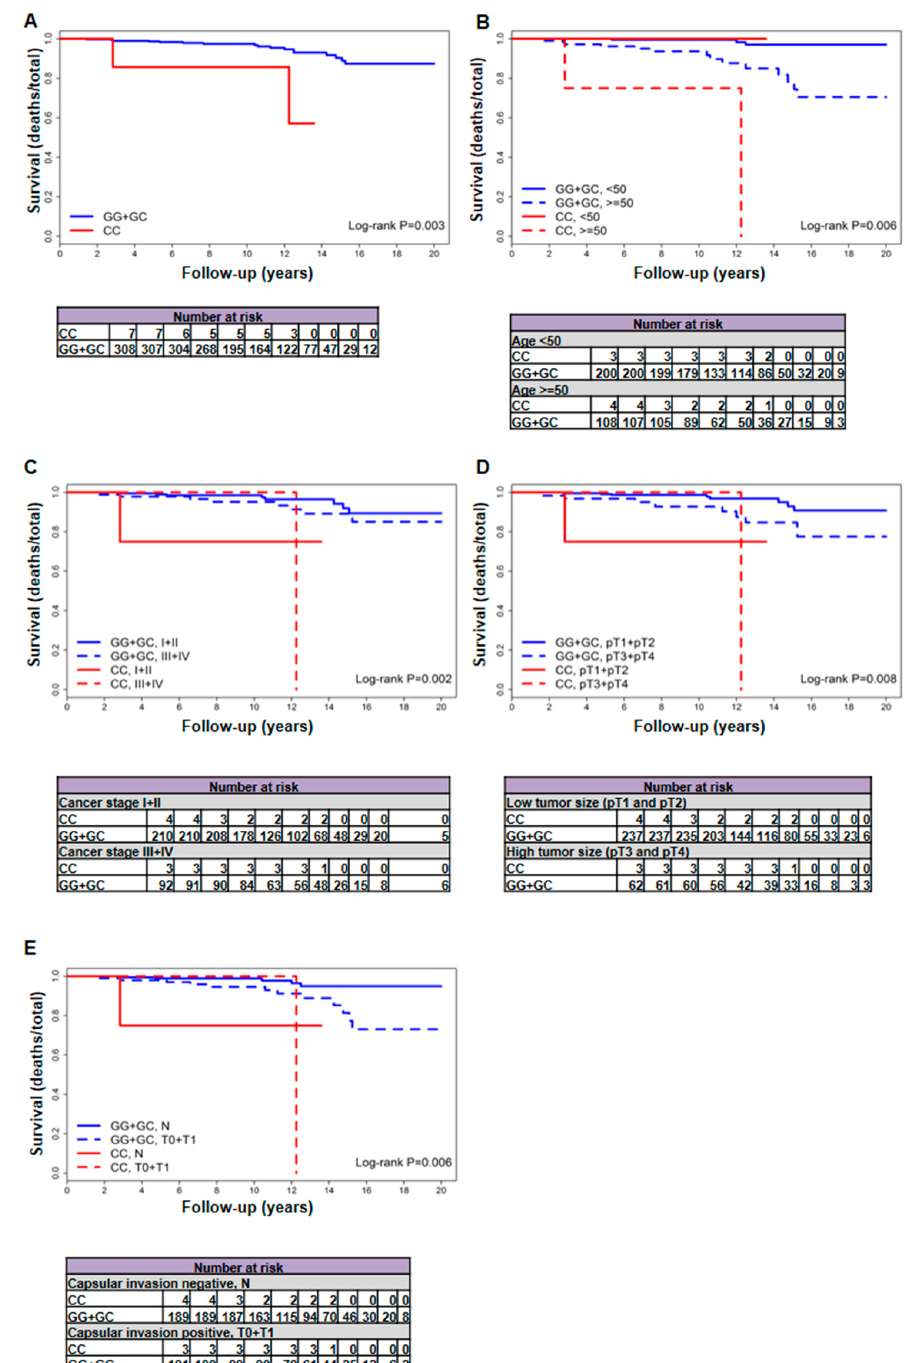
Figure 1. Interaction between rs2910164 and clinical factors in shaping the overall mortality Kaplan–Meier survival curves of the interaction of rs2910164 variant with the overall survival ( A ) and the clinicopathological risk factors: age at diagnosis ( B ), clinical cancer stage ( C ), tumor size ( D ) or capsular invasion ( E ) in patients with follicular variant of papillary thyroid carcinoma. In all panels, follow-up time is truncated at 20 years. In each panel, p values are from the log-rank test.